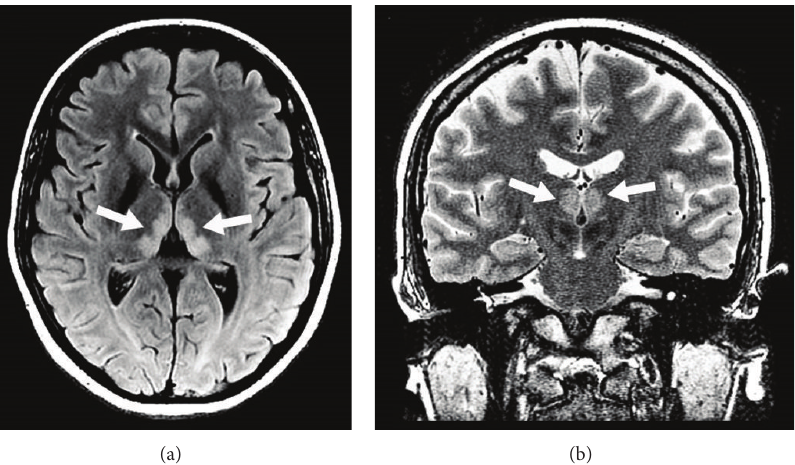
Figure 12: A patient with Wernicke syndrome showing hyperintensities in the medial part of the thalami on axial FLAIR (a) and coronal T2-weighted (b) imaging.